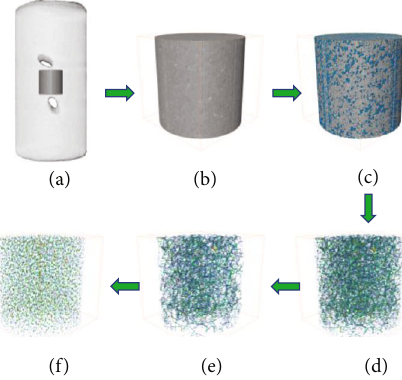
Figure 8: The work fl ow of extracting the pore network model. (a) Original volume. (b) The subvolume. (c) The binary subvolume. (d) The entire PNM, including nodes and links. (e) The nodes of the PNM. (f) Links in the